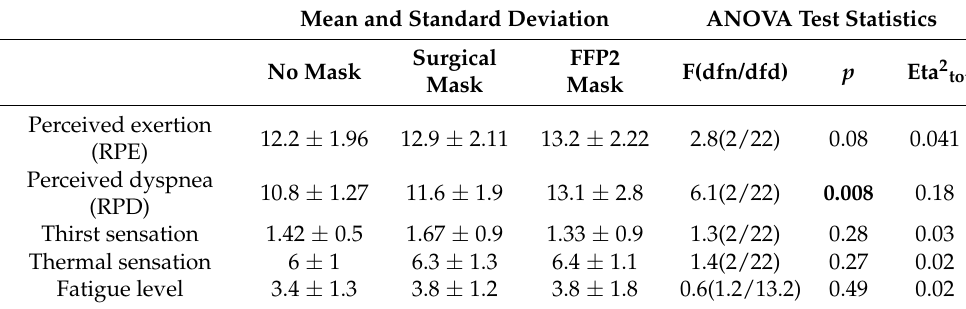
Table 1. Means, standard deviations, and test statistics of repeated-measures ANOVA. Mean and Standard